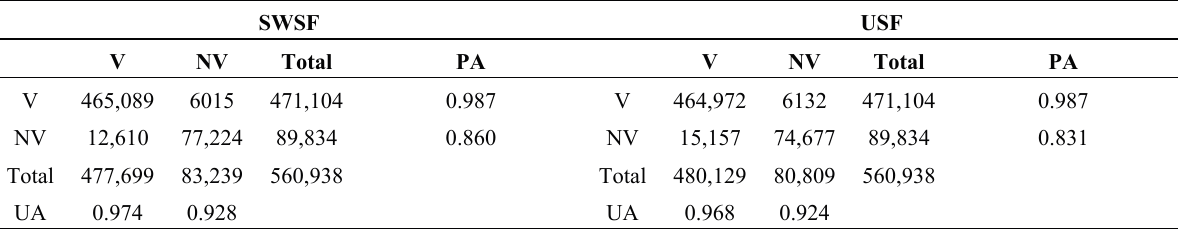
Table 2. Error matrices for the spatially-weighted segment-level fusion (SWSF) and USF object-based classifications (compared against the baseline higher spatial resolution (HSR) image classification). V, “vegetation”; NV, “non-vegetation”; PA, producer’s accuracy; UA, user’s accuracy; OA, overall accuracy; (cid:1863)(cid:3552) , kappa coefficient.